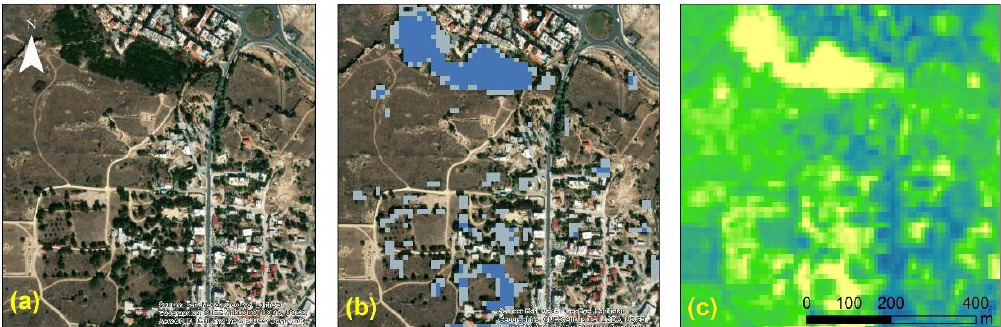
Figure 11. ( a ) High-resolution satellite image over the case study area, ( b ) difference between the results of Figure 9a,b and ( c ) Normalized Difference Vegetation Index (NDVI)—proportion of vegetation.